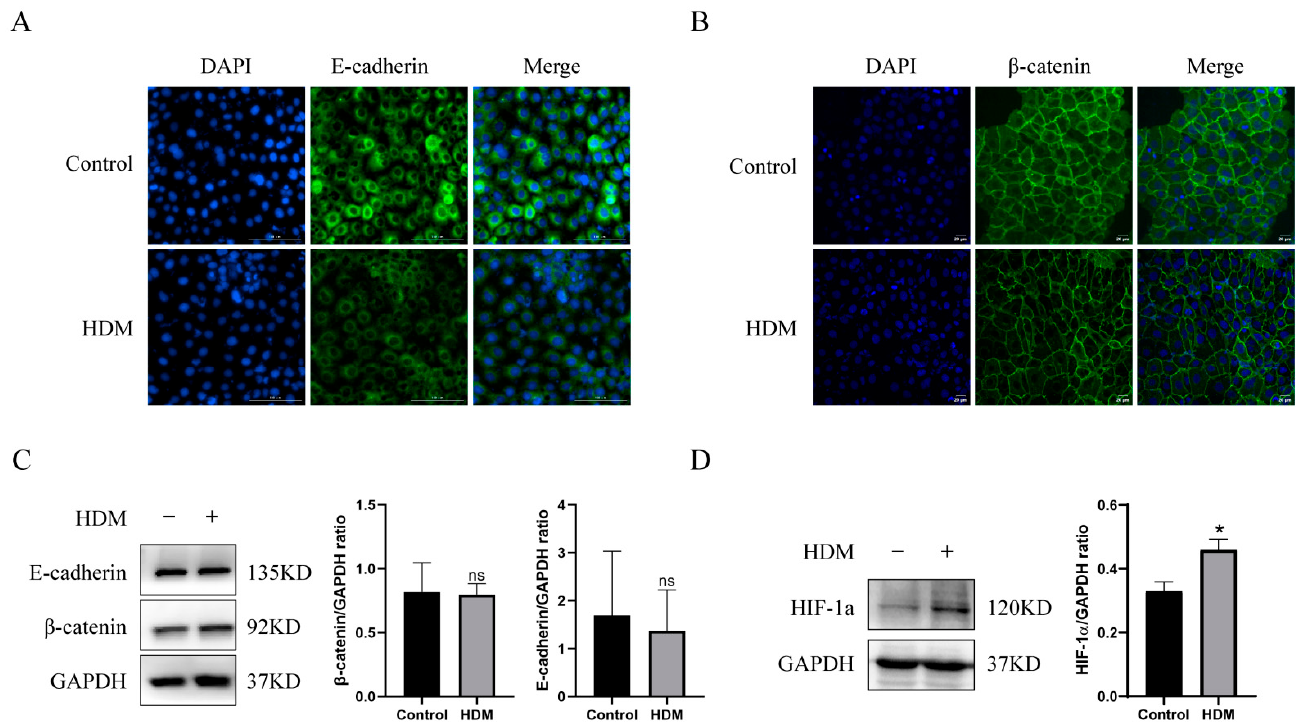
Figure 5. HDM induced delocalization of E-cadherin and β -catenin and promoted the expression of HIF-1a in 16HBE cells. ( A , B ) The distribution of E-cadherin and β -catenin were detected by immunofluorescence. ( C , D ) The expression of E-cadherin, β -catenin, and HIF-1a were detected by Western blotting. * Represents compared to the control group. * p < 0.05.